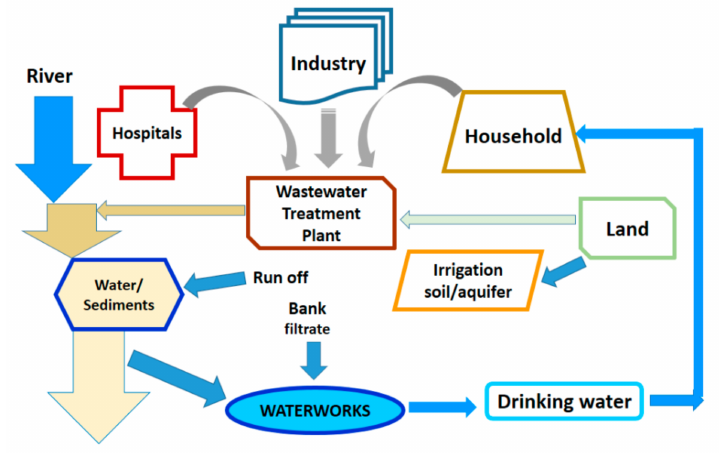
Figure 3. Origins of emerging pollutants and their routes in the environment (adapted upon https://www.norman-network.net/sites/default/files/files/Events/2006-2008/2006Jun19- 20-Stresa-EmEnvPollutants-KeyIssuesChallenges/03-sess1_ternes.pdf).